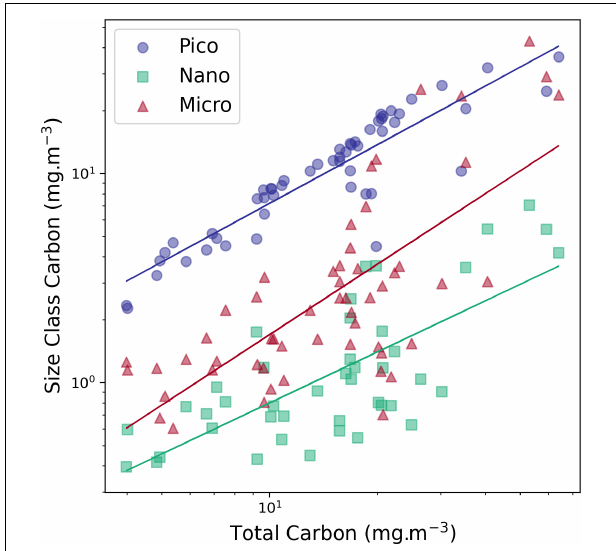
FIGURE 8 | Carbon concentration of each size class versus total carbon concentration (determined by FCor microscopy). picoplankton carbon (Pico Carbon, < 2 pg carbon cell − 1 ), nanoplankton, sum of carbon sizes 2, 3 and 4 ( > 2 < 180 pgC cell − 1 ) and microplankton carbon (Micro > 180 Carbon, > 180 pgC cell − 1 ). The correlation between each size class and TCarbon was significant ( p >